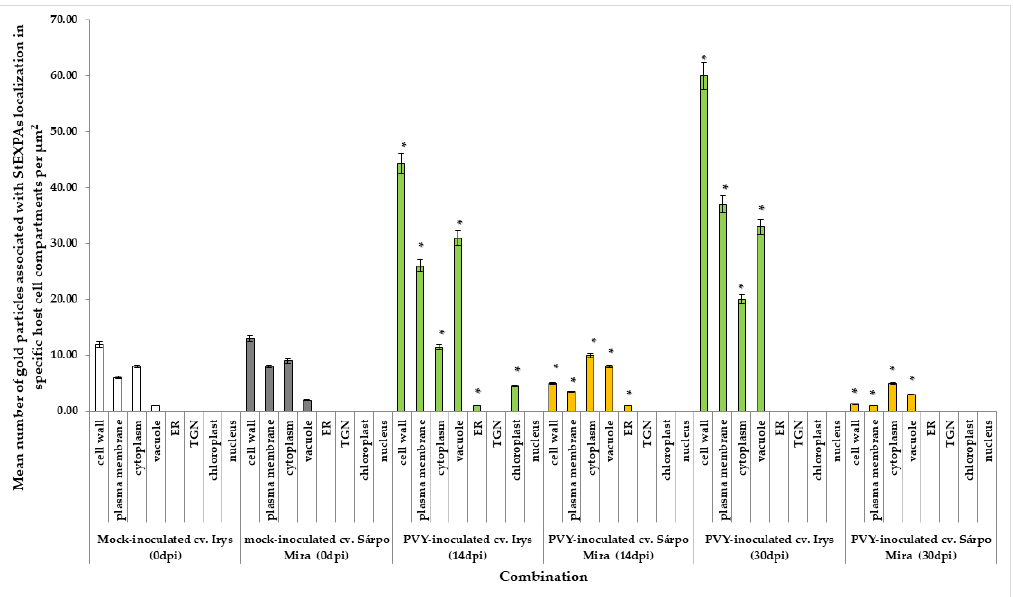
Figure5. StatisticalsignificanceassessmentofStEXPimmunogoldlocalizationinhostcellcompartments of mock-inoculated and PVY NTN -inoculated potato plants (susceptible and resistant). The figure presents the mean numbers of gold particles located in specific compartments per µ m 2 . The white charts present the StEXPAs in cell compartments of mock-inoculated cv. Irys at 0 dpi. The grey charts present the StEXPAs in cell compartments of mock-inoculated cv. S á rpo Mira at 0 dpi. The light green charts present StEXPA3 in PVY-inoculated cv. Irys at 14 dpi and 30 dpi. The orange charts present StEXPAs in PVY-inoculated cv. S á rpo Mira at 14 dpi and 30 dpi. Quantification immunogold localization was performed using ANOVA. Mean values of gold particle localization were evaluated at the p < 0.05 level of significance using post-hoc Tukey HSD test. Statistically significant values after mock or viral inoculation for both cultivars are marked by asterisks (*) above the